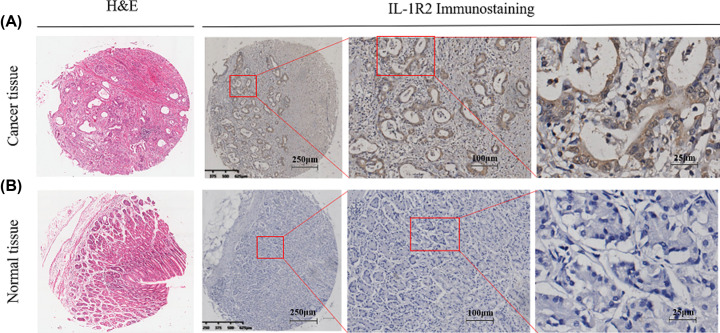
Immunohistochemical staining of IL-1R2 in GC tissues and normal
gastric tissue(A) High IL-1R2 expression in human GC tissues, and positive
staining of IL-1R2 might be found in the GC cell cytoplasm.
(B) The IL-1R2 was not expressed in normal gastric
tissues.